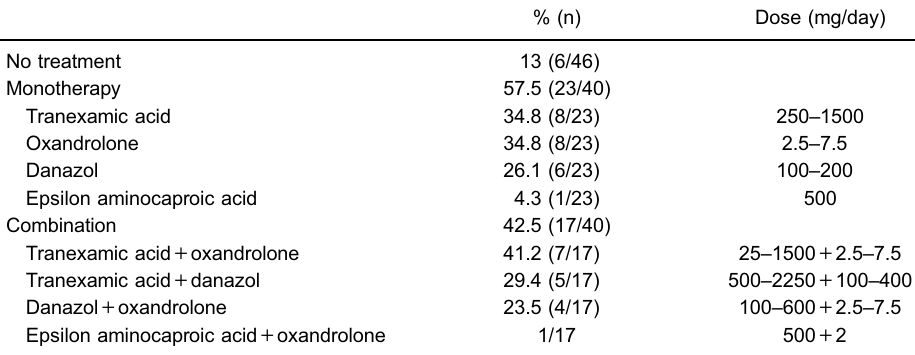
Table 2 . Prophylactic treatment of patients with hereditary